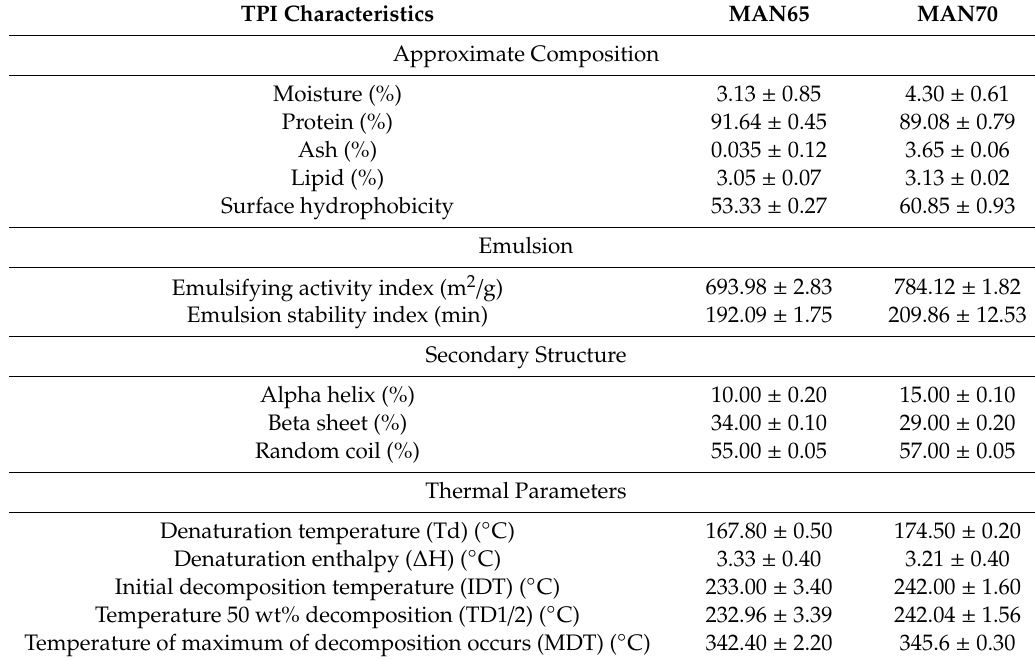
Table 2. The approximate composition, surface hydrophobicity, emulsion and thermal properties of thraustochytrid protein isolates (MAN65 and MAN70) extracted at pH 12.0 and 25 ◦ C.